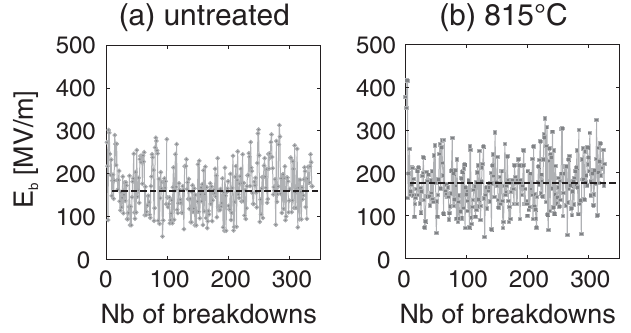
FIG. 7. Effect of 815 (cid:1) C heat treatment on Cu.